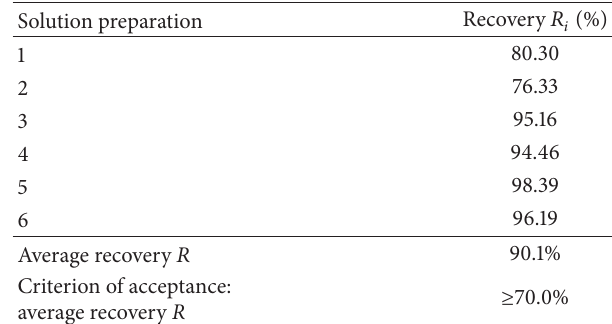
Table 7: Results of